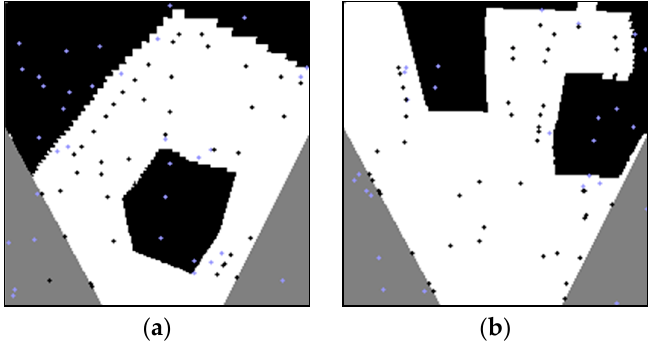
Figure 18. Effect of the collision cost C collision in the enhanced A* path: ( a ) having one obstacle at the bottom of the environment, ( b ) having two obstacles at the top of the environment. The outcome demonstrates that path cost moves random blue points to the closest points along the intended path in Figure 19.